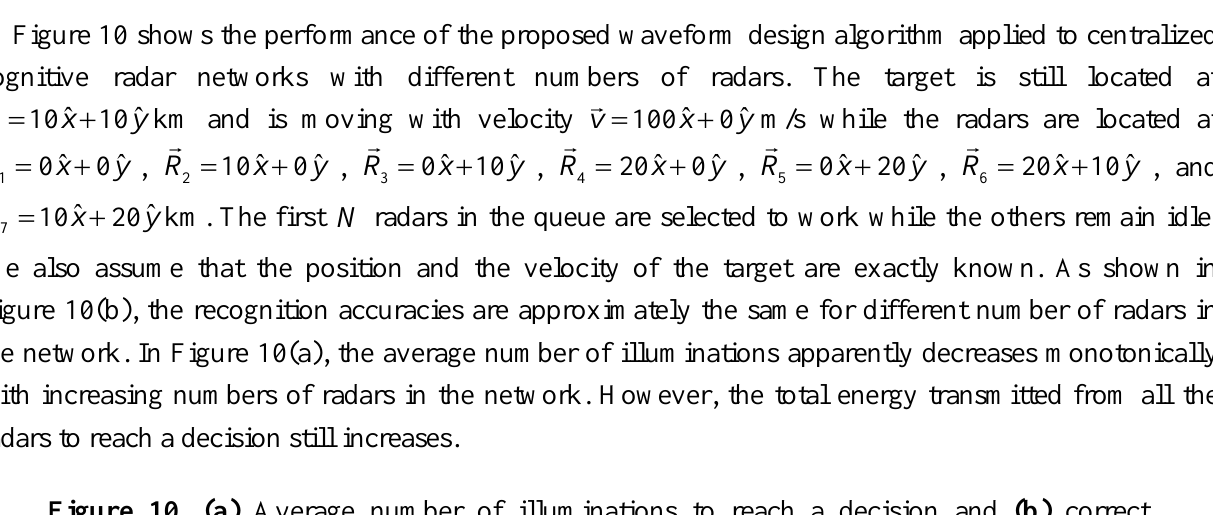
Figure 10. (a) Average number of illuminations to reach a decision and (b) correct recognition rates at the time when a decision has been made vs. energy per illumination for different numbers of radars in the